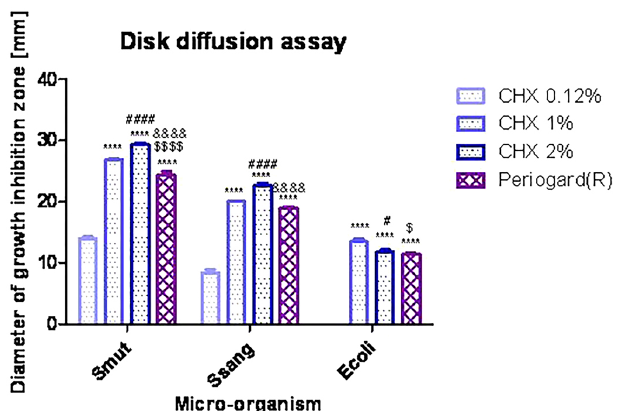
FIGURE 1 - Disk diffusion assay (measurement of growth inhibition zones, in millimeters) for standard antimicrobial drugs and Periogard ® against oral-occurring micro-organisms, analyzed by two-way ANOVA and Bonferroni’s post test (p<0.05). Statistically significant differences were found among CHX 0.12% x CH 1%, CHX2% and Periogard ® (*); CHX1% x CHX2% (#); CHX1% x and Periogard ® ($) and CHX2% x and Periogard ® (&). CHX=chlorhexidine; Smut= Streptococcus mutans ; Ssang= Streptococcus sanguinis ; Ecoli= Escherichia coli significance, as follows: treatments account for 45.31%